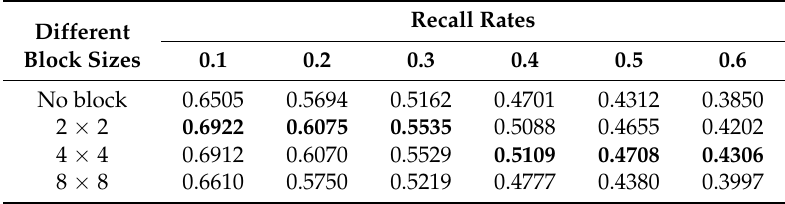
Table 1. Retrieval precision of different block sizes on the database Corel-1k with { λ 1 = 1, λ 2 = 0 } .